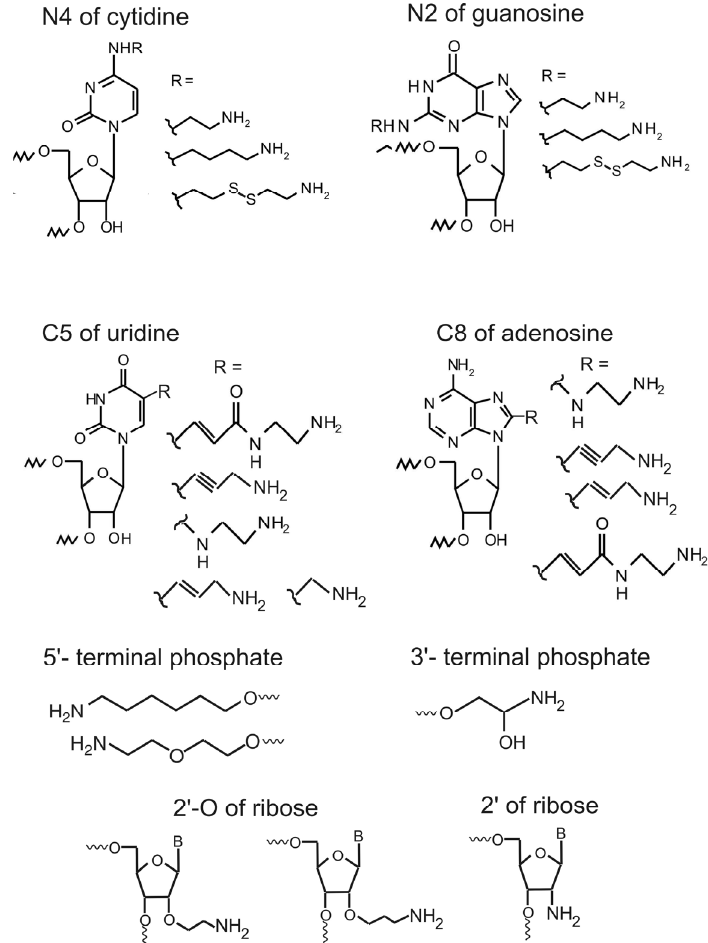
Figure 1. Examples of amino linker-modified RNA nucleotides grouped by the sites of the linker attachment (the respective references are given in the